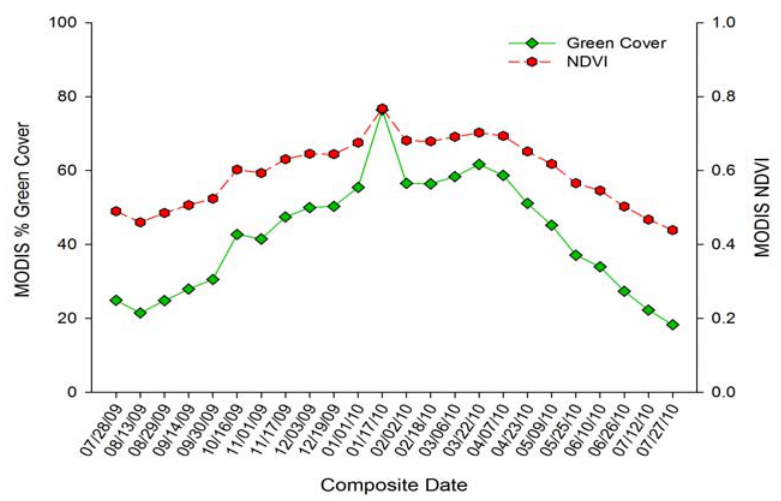
Figure 6. MODIS NDVI seasonal variation (August 2009–August 2010) and distribution of MODIS based % green cover along the 2009–2010 hydrological